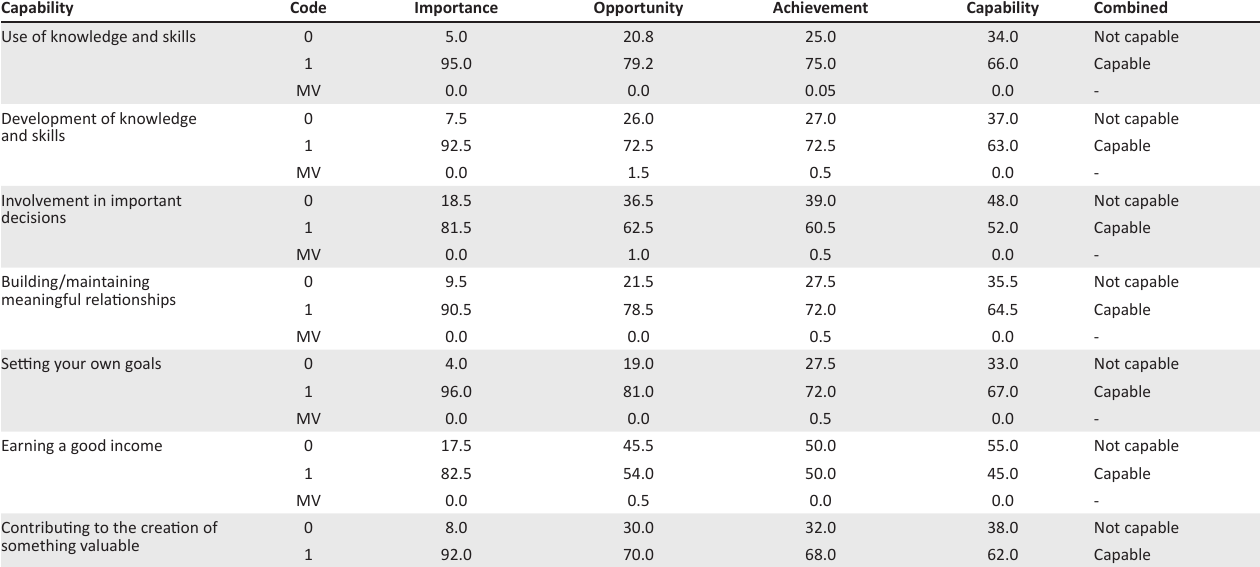
TABLE 2: Percentages of teacher capabilities.